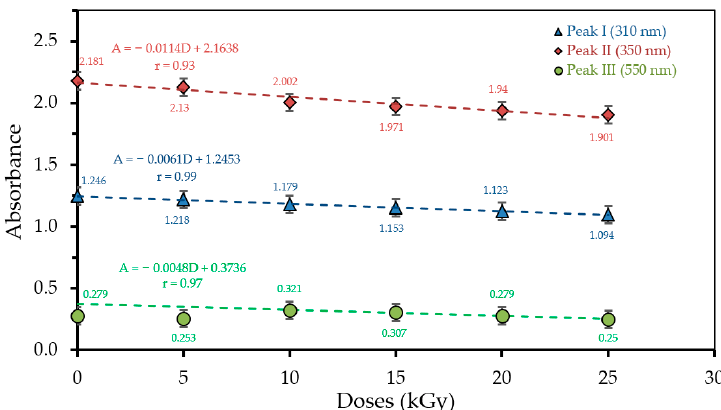
Figure 2. The relationship between radiation dose and absorbance of each λ (310, 350, and 550 nm) for H 3 PO 4 75 v% concentration. For peak III, the first two absorbance data were considered as outliers when plotting the trendline.